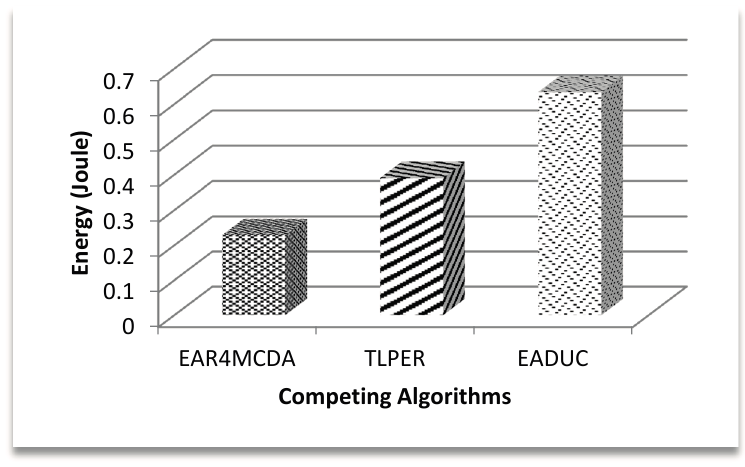
Figure 9. Average energy consumption for transmitting one packet from end to